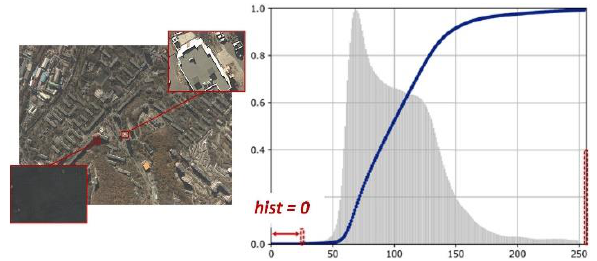
Figure 9. An example of an image with haze and information loss in shadows and illumination, detected by histogram Numerically, information loss in shadows and illumination can be estimated as percentage of total number of pixels in the image, i.e. the percentage of information loss in shadows is the ratio of number of pixels with minimum value (if there is a histogram outlier at this pixel value (see Figure 9) to total number of pixels in the image; and the percentage of information loss in illumination is the ratio of number of pixels with maximum possible value, provided by image’s radiometric resolution (255 for radiometric resolution 8 bits/pixel) to total number of pixels in the image.